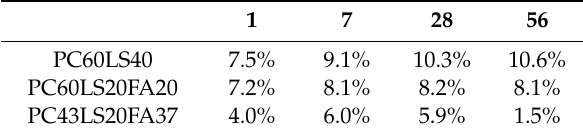
Table 7. Comparison of the Ca(OH) 2 content of the selected